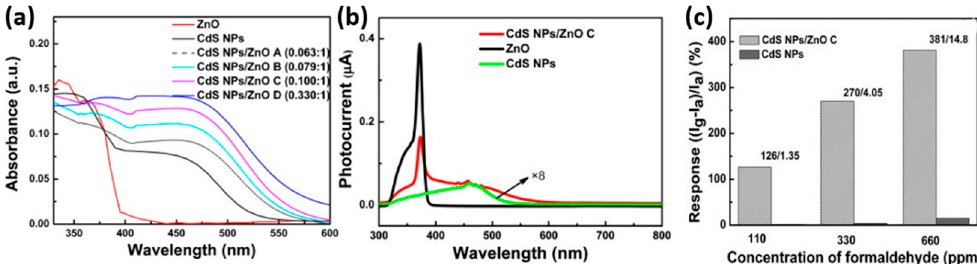
Figure 48. ( a ) UV-vis diffuse reflectance spectra; ( b ) photocurrent of ZnO, CdS NPs and the CdS NPs/ZnO A, B, C and D (A, B, C and D: mass ratios of CdS/ZnO were 0.063:1, 0.079:1, 0.100:1 and 0.330:1, respectively); ( c ) Formaldehyde sensing response under visible light illumination of CdS and CdS NPs/ZnO C. Reproduced with permission from [10].